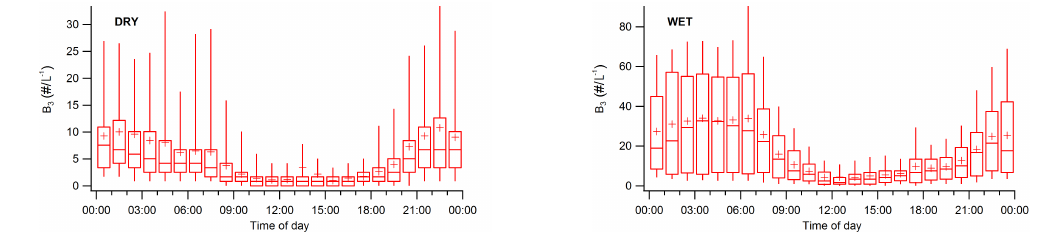
Fig. 4. As Fig. 3 but showing cluster B 3 during dry periods (top), and wet periods (bottom).